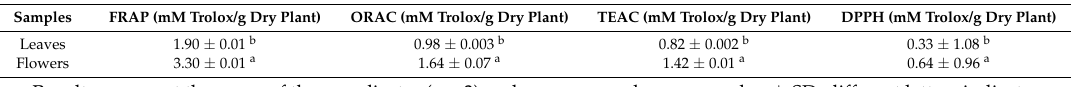
Table 2. Antioxidant activity of A. vulneraria leaf and flower extracts extracted with 50% aqueous ethanol.